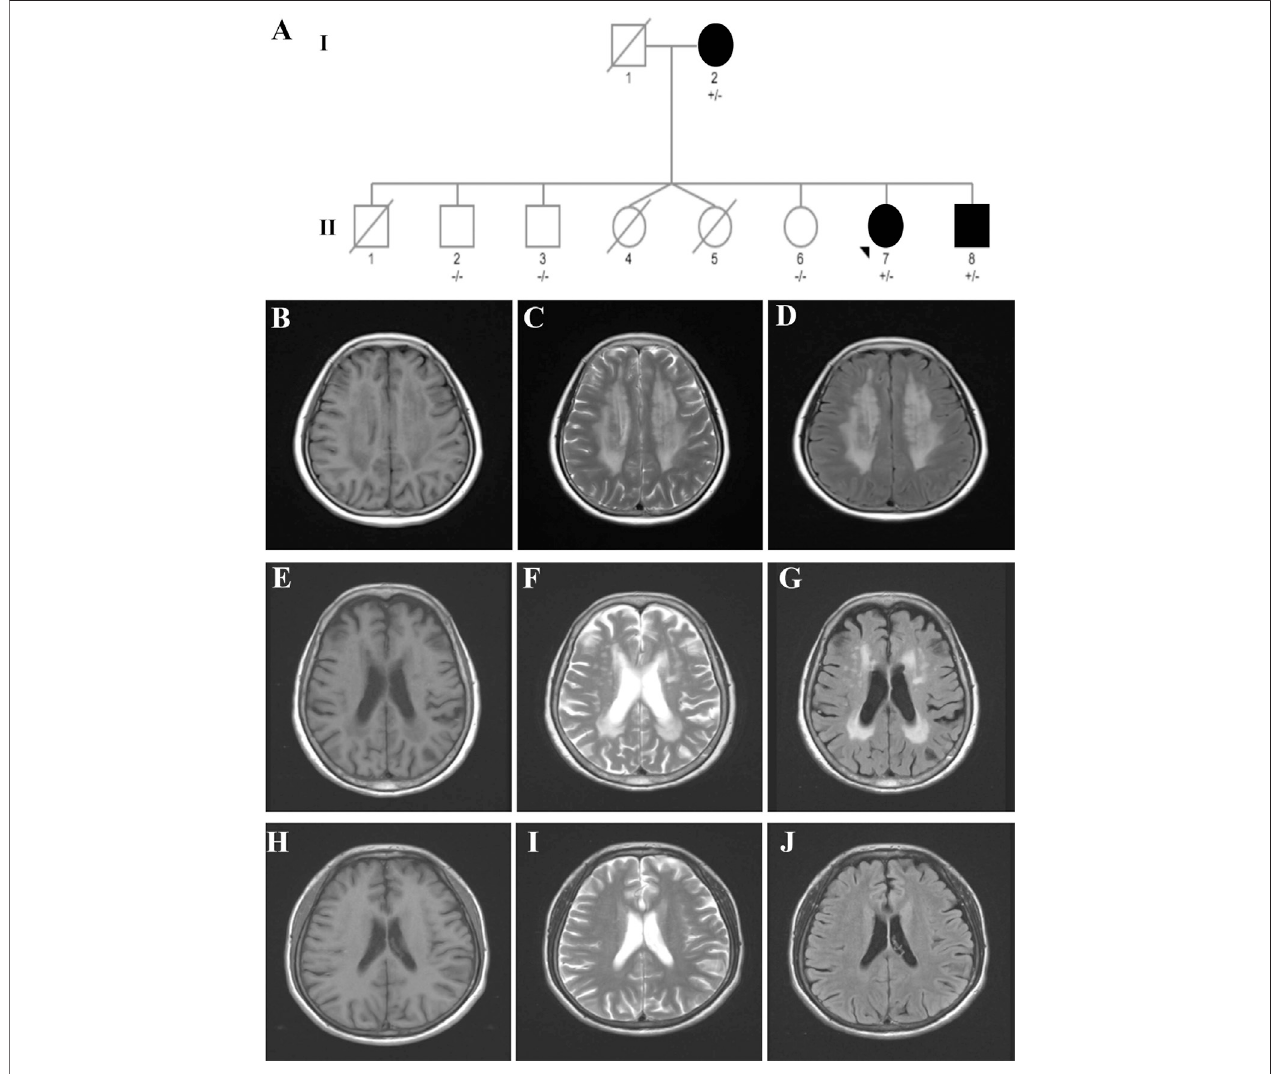
FIGURE1| PedigreeofafamilyaffectedbyVWM. (A) PedigreeoftheVWM-affectedfamily. (B – D) BrainMRIoftheproband (caseII-7)indicatingtypical symmetric and diffuse periventricular leukoencephalopathy and a cerebrospinal fl uid-like signal within the area on T1-weighted (B) , T2-weighted (C) , and fl air images (D) . (E – G) Brain MRI of the mother (case I-2) showing moderate leukoencephalopathy. (H – J) Brain MRI of the brother (case II-8) revealed no leukoencephalopathy.